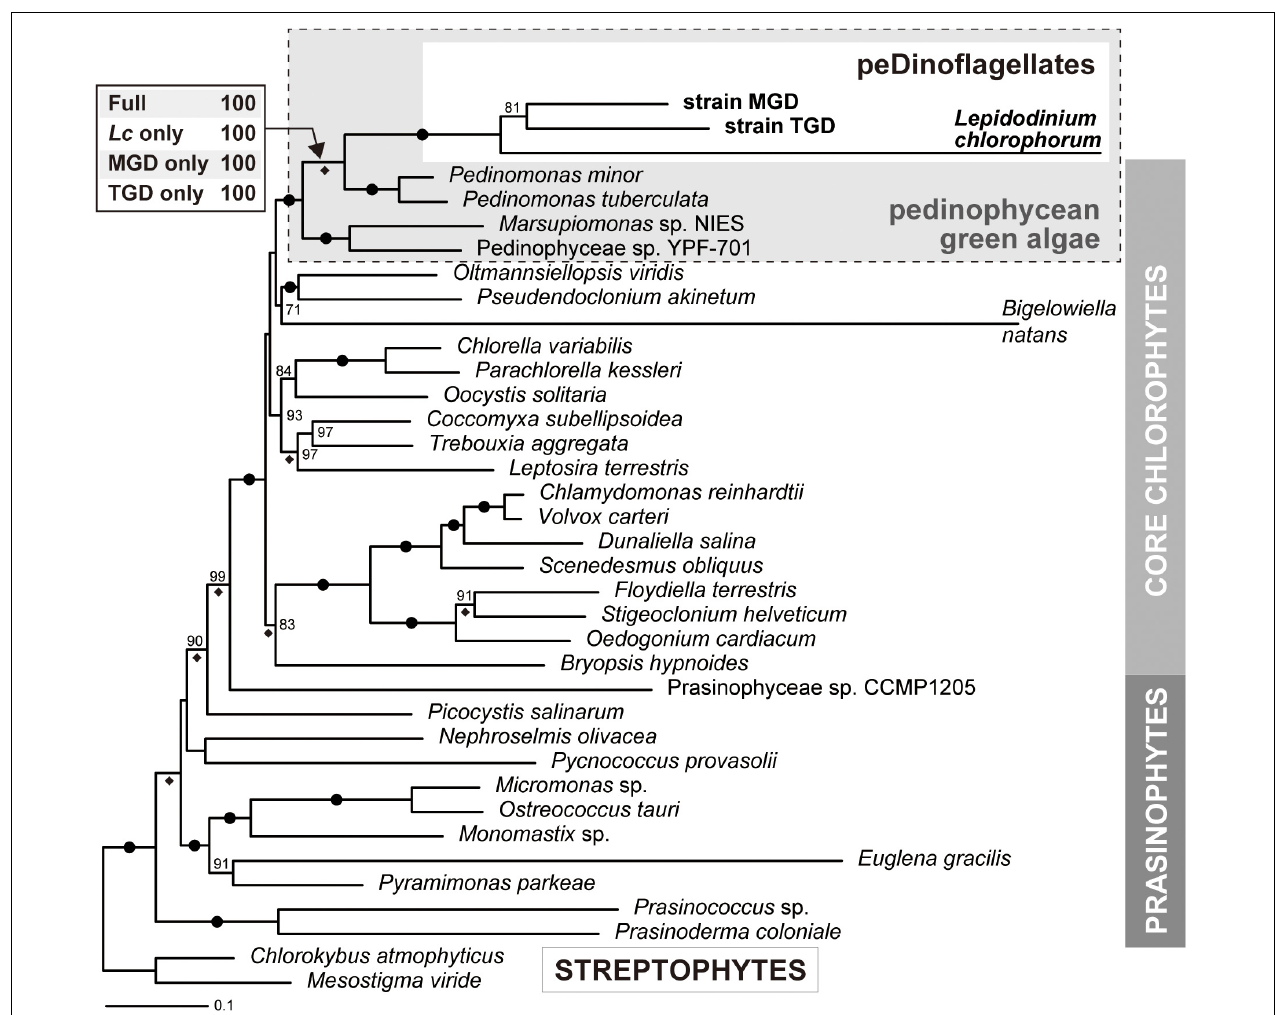
FIGURE 4 | Phylogeny of green algal plastids and green alga-derived plastids inferred from the alignment comprising 50 plastid-encoded proteins. The maximum-likelihood (ML) tree and non-parametric ML bootstrap support values (MLBP) are shown here. The overall tree topology inferred from Bayesian method agreed with the ML tree. Dots on branches indicate the bipartitions received MLBPs of 100% and Bayesian posterior probabilities (BPPs) of 1.0. Only MLBPs greater than 70% are shown. The bipartitions supported by BPPs of 1.0 are marked with diamonds. For the node uniting the three peDinoflagellates and pedinophycean green algae, the MLBPs calculated from the four ML bootstrap analyses are presented. “Full,” the analysis considering the three peDinoflagellates; “ Lc only,” “MGD only,” and “TGD only,” those considering Lepidodinium chlorophorum , strain MGD, and strain TGD considering the sole representative of peDinoflagellates,